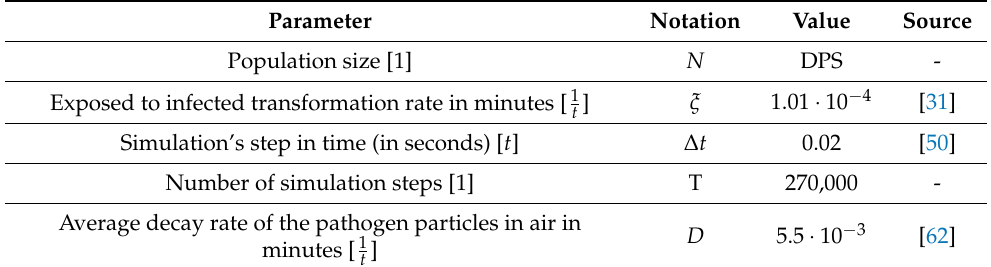
Table 1. The model’s parameters with their default values. DPS stands for differing per simulation which means the value is dependent on the specific instance of the simulation